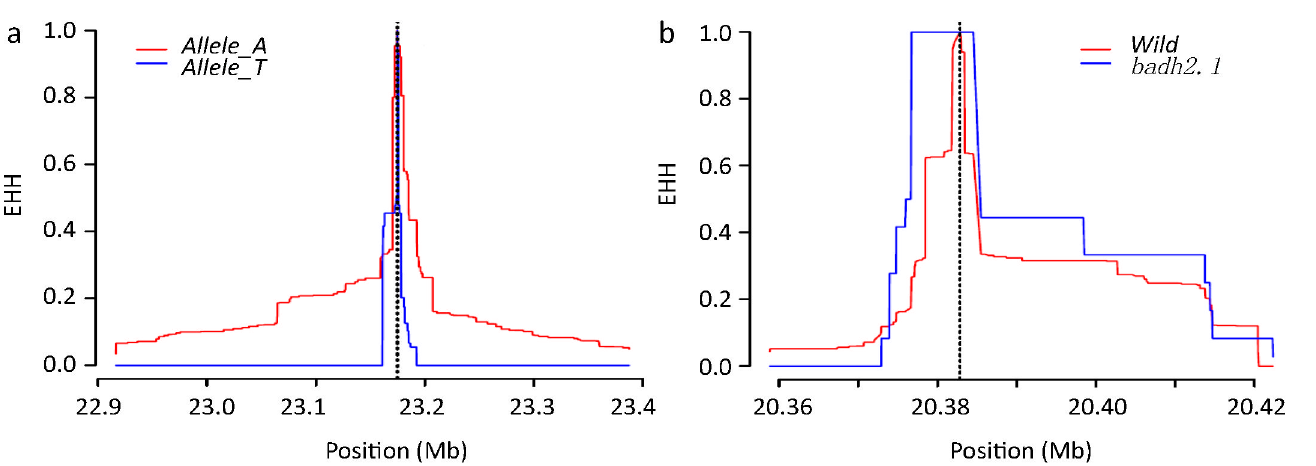
Fig 3. Boxplot of STI (salt tolerance index) for different allele type at P1 1483 (T/A).